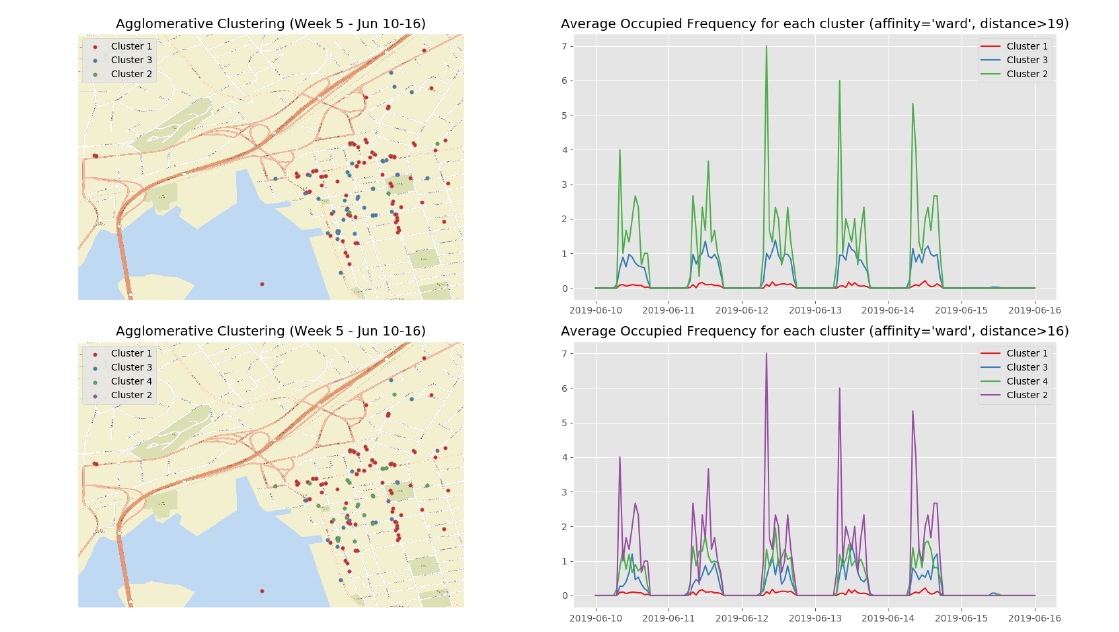
Figure A6. Clustering results for the 5th week.